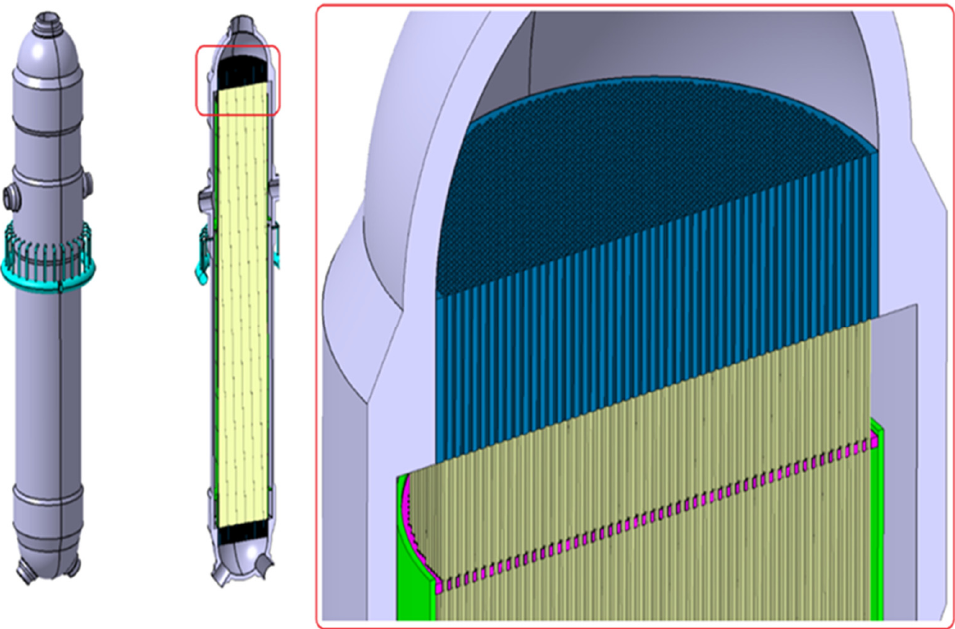
Figure 2. BZ OTSG 3D CATIA CAD